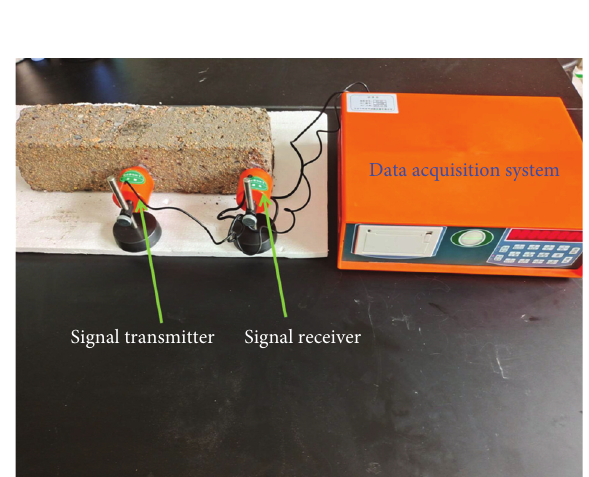
Figure 1: Measurement of the DME of the samples.